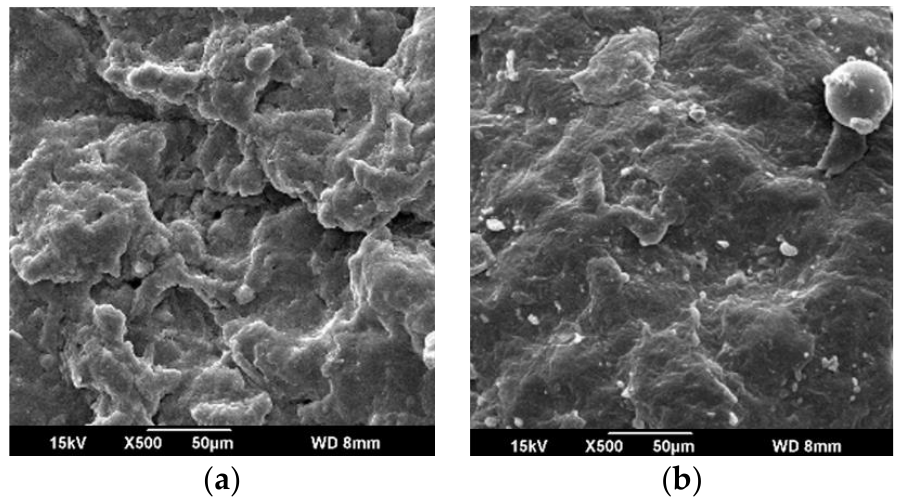
Figure 8. SEM diagram of materials in screw space. ( a ) Material in filtration section. ( b ) Material in extrusion section.